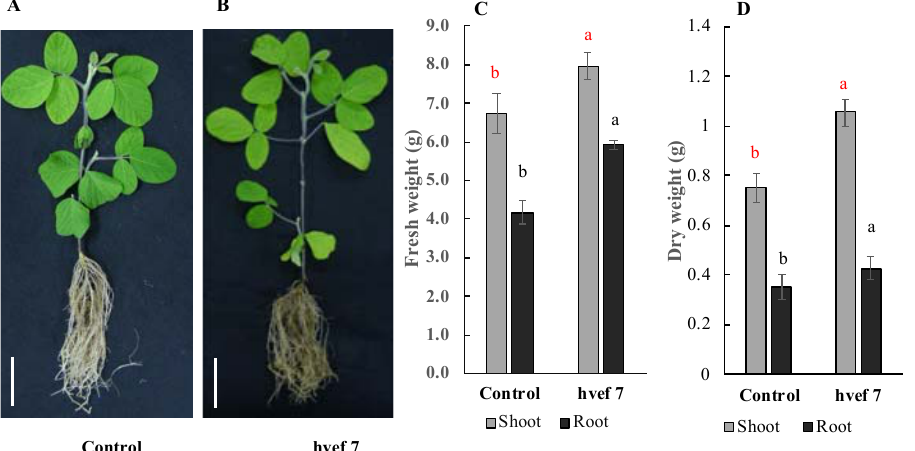
Figure 6. Soybean plant without inoculation (A) and with inoculation of hvef7 (B), soybean shoot and root fresh weights (C), shoot and root dry weights (D) after 25 days inoculation with hvef7 ( Cladosporium cladosporioides ) compared with control plants. Data were statistically different at p < 0.05 as assessed by one-way ANOVA with Tukey’s test (n= 5); means ± SD. For each inoculation treatment, bars with different letters (a, b) indicate that the mean values are significantly different at a significance level of p < 0.05. In this study, the antagonistic potential of the isolated fungi against Calonectria ilicicola growth with the pathogen were classified as competition for the substance and